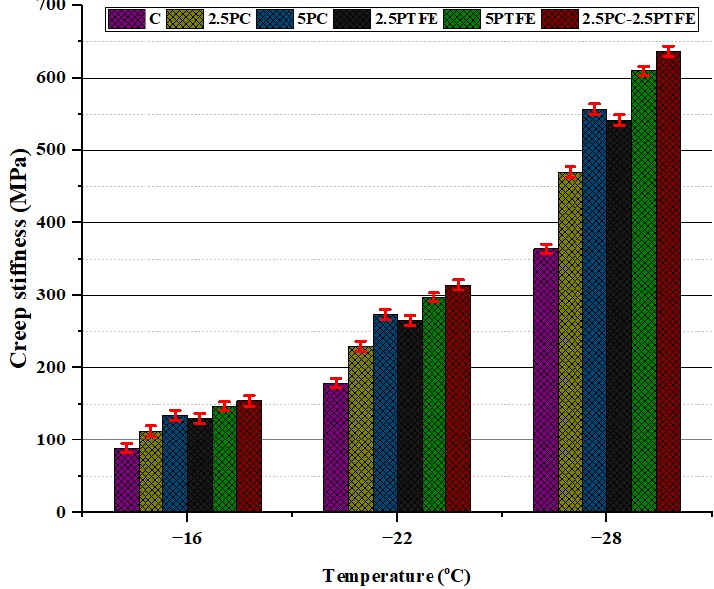
Figure 12. Effects of PC and PTFE on the creep stiffness of PG 70.